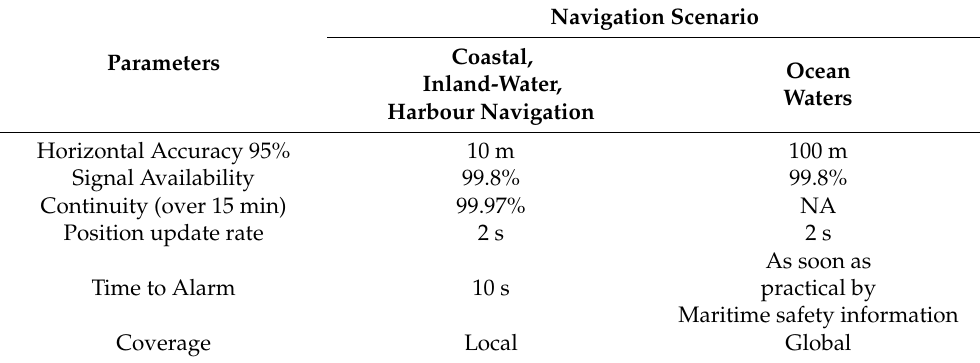
Table 1. Requirements for a general maritime navigation established in the IMO Resolution A.1046 (27)